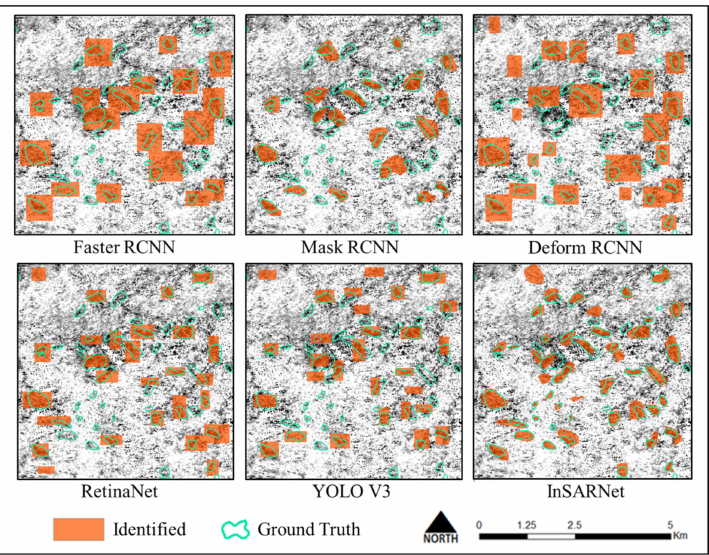
Figure 25. Comparison of different models in test area